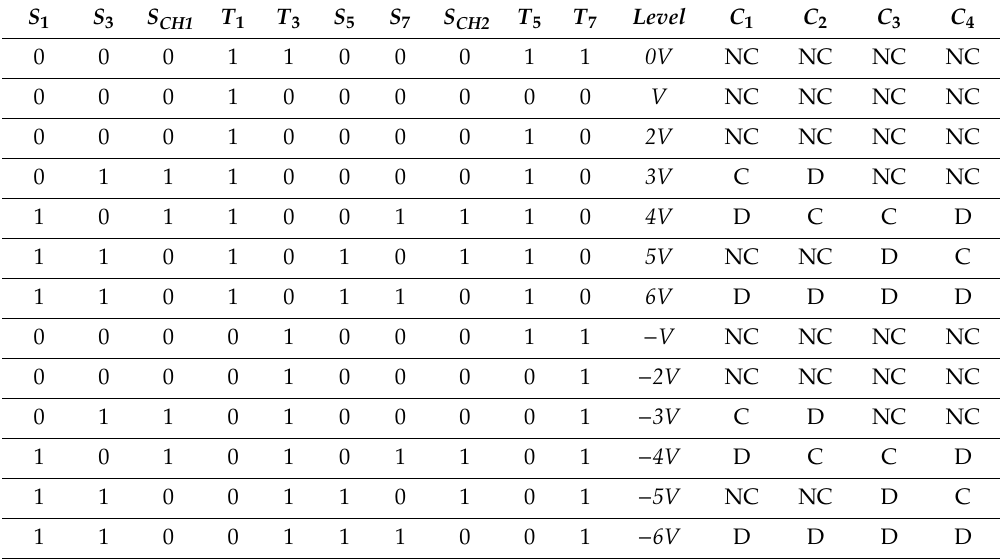
Table 2. Switching states of the proposed symmetrical 13 level